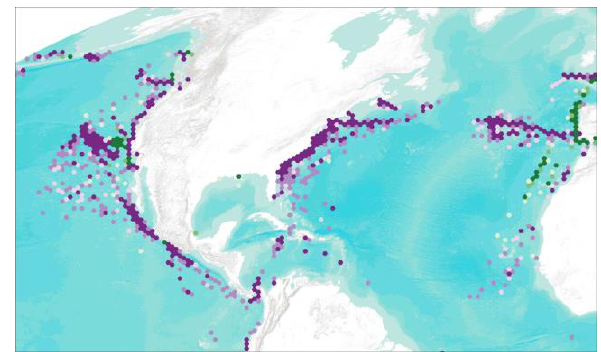
Figure 10 Trend analysis on counted AIS’ positions over all bin locations, focus on the Trans-Atlantic and Trans-Pacific (North America west coast) routes. (Basemap sources: Esri, USGS, NOAA).